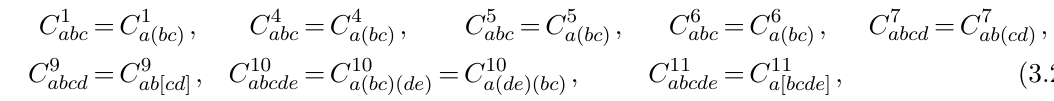
, I 13 , and Xij Xij